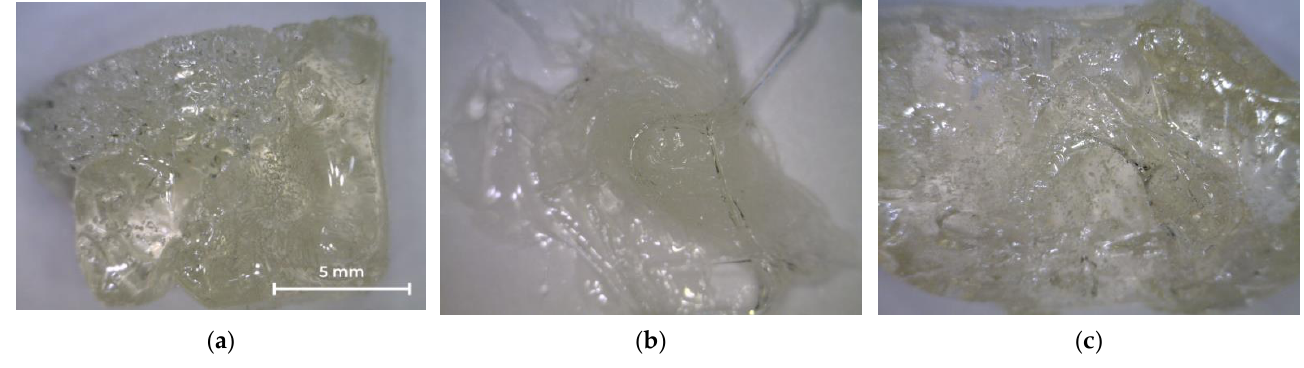
Figure 3. Photos of OEP-1, ODEP-1, and OPP-1 samples: ( a ) OEP-1; ( b ) ODEP-1; ( c ) OPP-1. Table 3. Characteristics of OEP-1, ODEP-1, and OPP-1 samples: number average (Mn) and weight average (Mw) molecular weights, polydispersity index (PDI), conversion, and color.